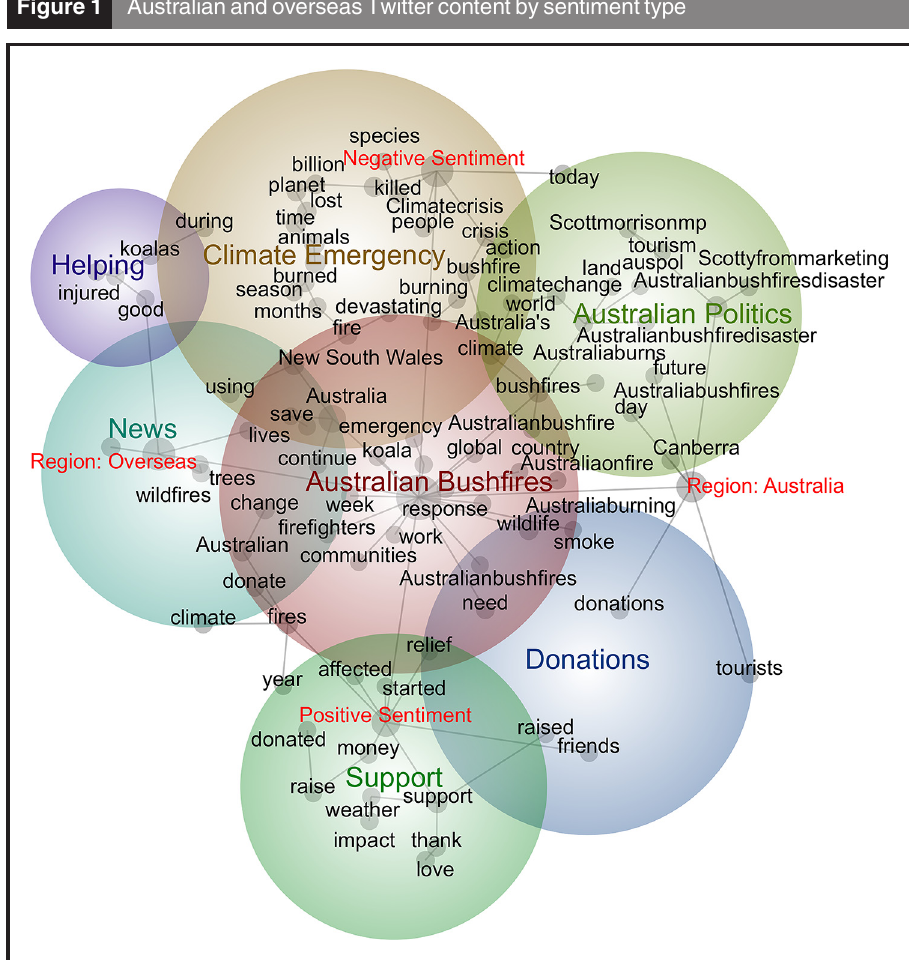
Figure 1 Australian and overseas Twitter content by sentiment